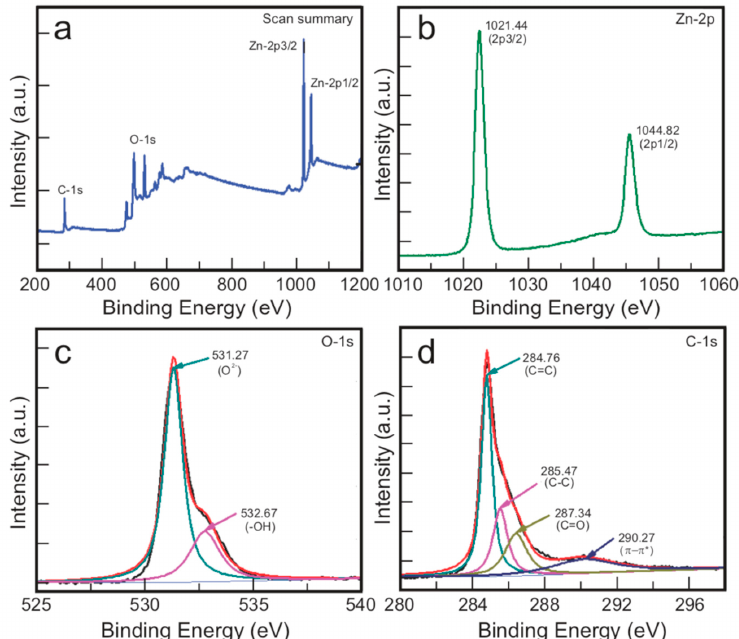
Figure 4. XPS spectra: ( a ) survey spectrum of the prepared ZnO–SWCNT nanocomposite and high-resolution spectra showing ( b ) the Zn-2p 3/2 and Zn-2p 1/2 peaks, ( c ) the O-1s core level, and ( d ) the C-1s core level of the ZnO–SWCNT nanocomposite.